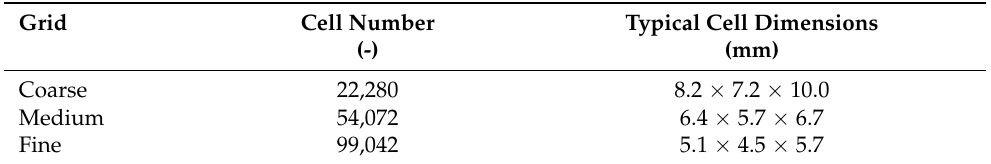
Table 7. Cell number and typical cell dimensions of the investigated grids for the simulation of the spouted bed.